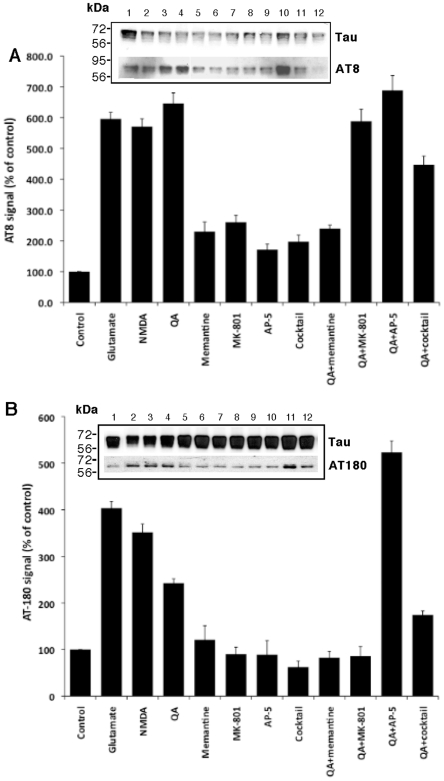
QA-induced tau phosphorylation occurs through the activation of NMDA receptor, and memantine inhibits QA-induced tau phosphorylation:Primary cultures of human neurons were treated with 500 nM each of three NMDA receptor agonists (QA, glutamate and NMDA) and three antagonists (memantine, MK-801 and AP-5). One well (termed as cocktail) was treated with a combination of all the three antagonists (500 nM each). Control wells were cultured in medium alone. Cells were cultured for 24 hours and were then lysed in RIFA buffer. 20 µg of protein lysate was resolved on 10% SDS PAGE, transferred onto PVDF membrane and probed with phosphor-specific antibodies AT8 and AT180 (1∶100 dilution). Antibody Tau (DAKO, 1∶10000) was used for total tau. Quantization data is presented as ratios of AT8 and AT-180 signal to total tau signal and is the average (±SD) of three experiments. A representative blot is for each graph is shown in the insert.